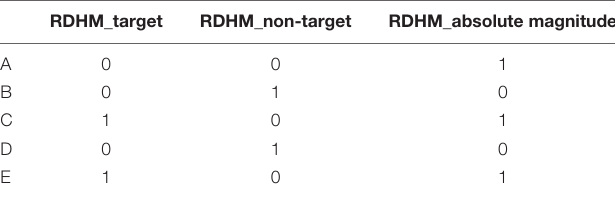
TABLE 1 | RDHM for each heuristic and type of trial in Figure 1